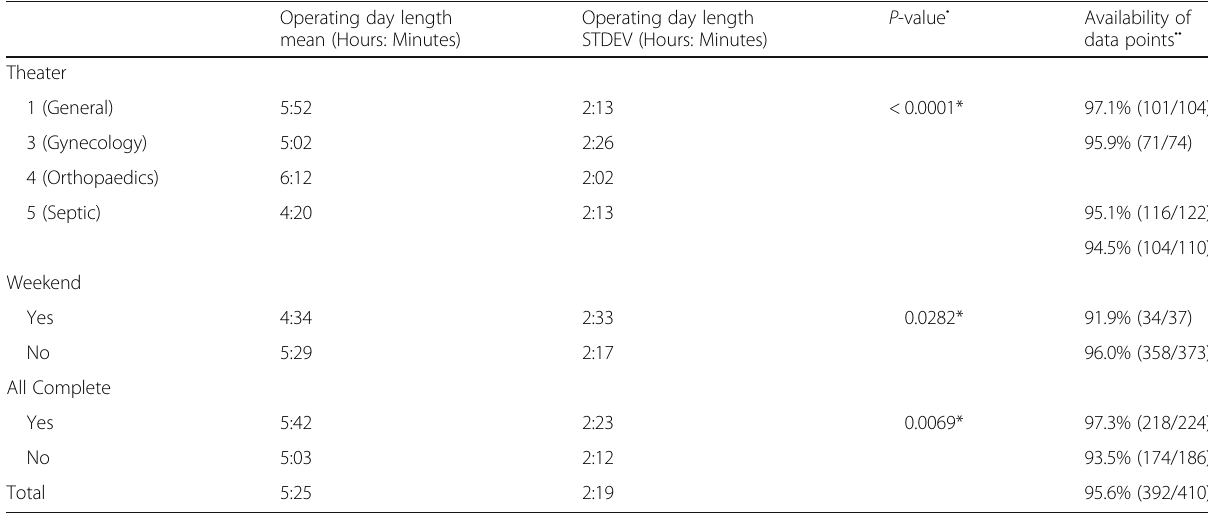
Table 5 Elective operating day